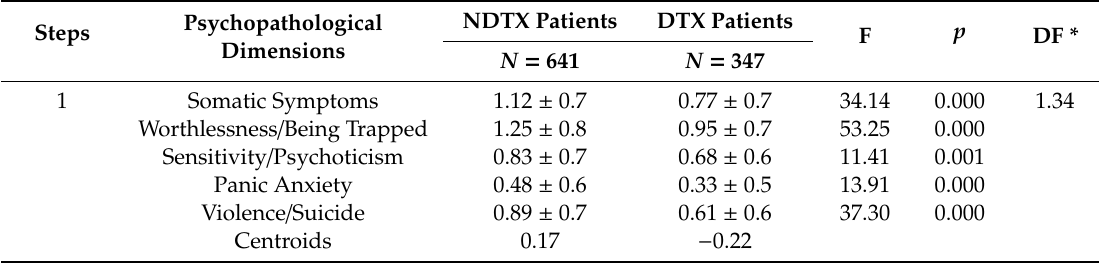
Table 1. Di ff erences in severity of psychopathological dimensions between non-detoxified (NDTX) and detoxified (DTX) heroin-dependent subjects: stepwise discriminant